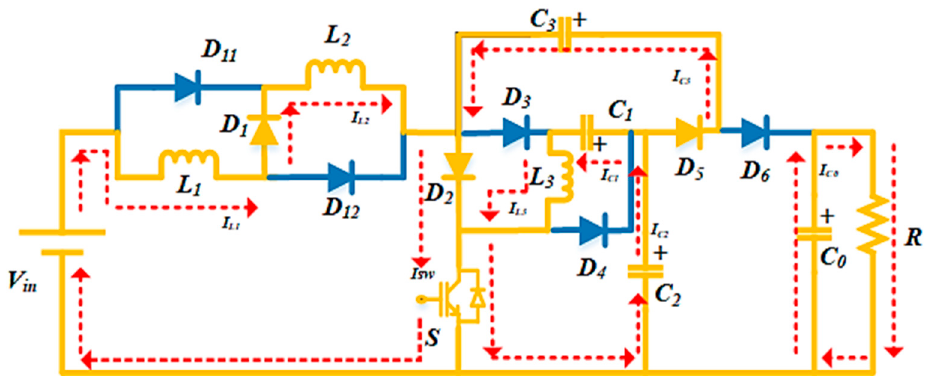
Figure 5. HG-SIQBC—equivalent circuit for Mode I. (The conducting portion of the circuit is shown in Yellow color with the current flow in dotted lines).